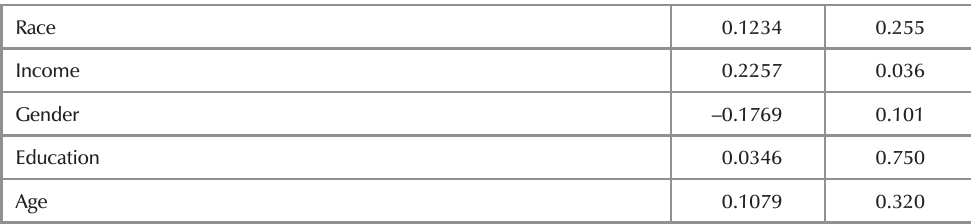
Table 4 above indicates the absence of multicollinearity between WTP and the independent variables selected. The analysis of